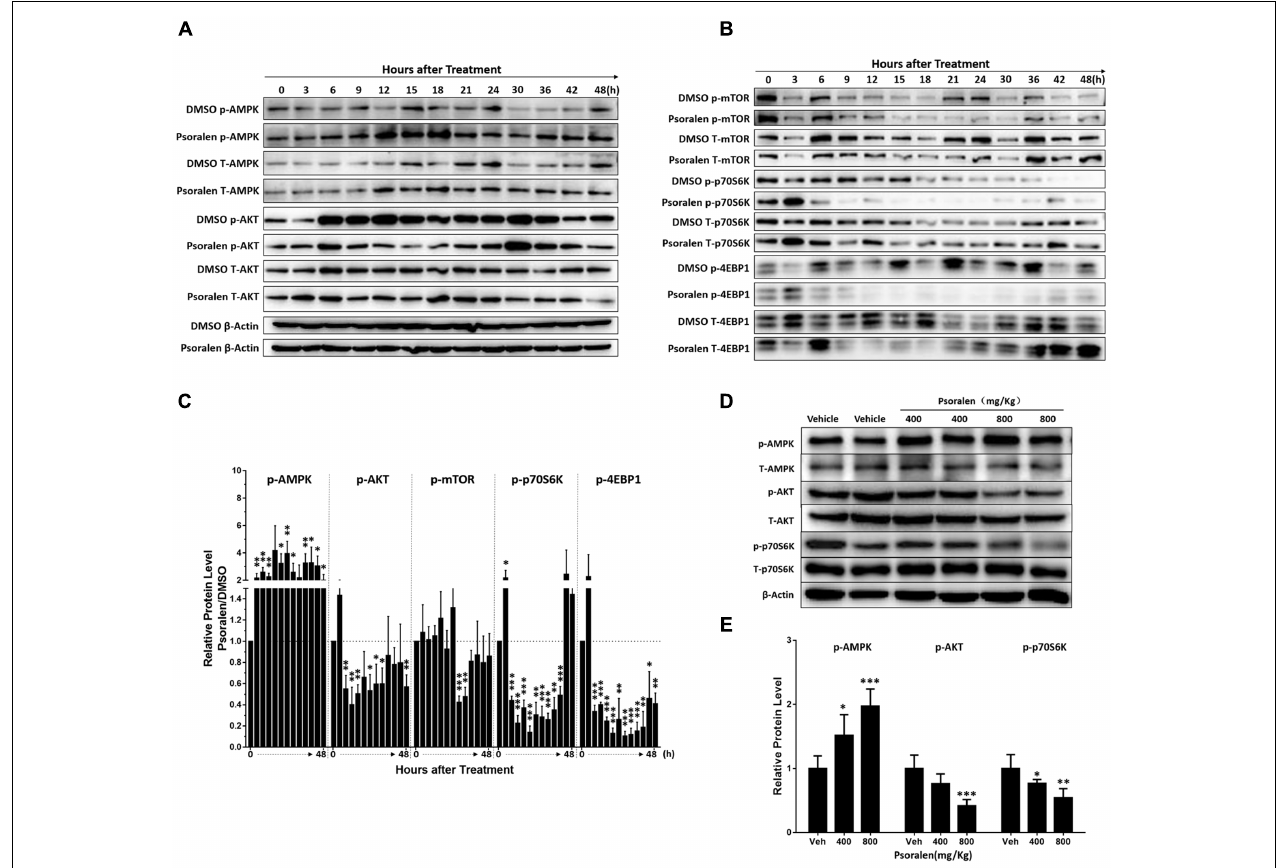
FIGURE 7 | Changes in mTOR signalling pathway-related proteins after psoralen treatment in L02 cells and mice. L02 cells were treated with DMSO or psoralen and incubated for various time periods. When the cells were just beginning to completely adhere (defined as 0 h), the total protein was collected successively every 3 and 6 h during a 48 h period. All experiments were performed three times independently. (A,B) Representative immunoblots for the protein levels of total AMPK, AKT, mTOR, p70S6K, and 4EBP1 and their phosphorylated forms. (C) The correspondingly relative protein levels were quantified by scanning band intensity and normalised to β -actin. The density of immunoreactive bands was quantified using ImageJ software. Density values were normalised to β -actin and then expressed as the relative expression levels between DMSO-treated and psoralen-treated. C57BL/6 mice were treated with 0.5% CMC-Na solution (vehicle group), or 400 mg/kg or 800 mg/kg psoralen for 24 h. (D) Representative immunoblots for the protein levels of total AMPK, AKT, and p70S6K, and their phosphorylated forms. (E) The correspondingly relative protein levels were quantified by scanning band intensity and normalised to β -actin ( n = 6). Data are means ± SDs ( n = 6). ∗ p < 0.05, ∗∗ p < 0.01, ∗∗∗ p < 0.001 versus DMSO group or vehicle